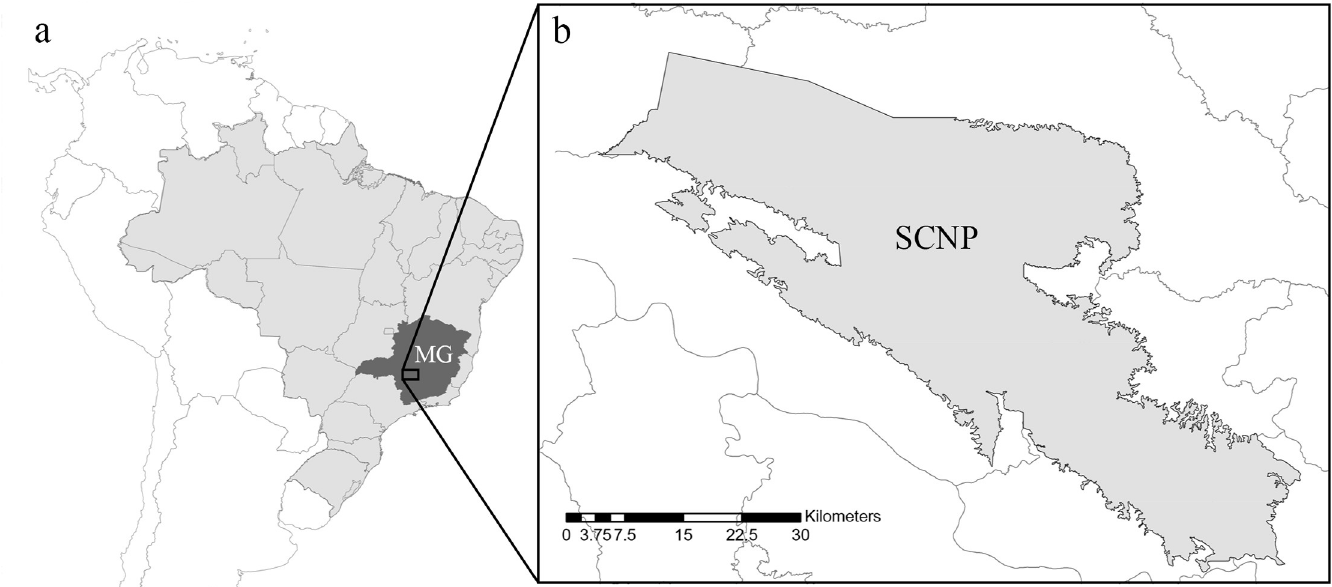
Fig 1. Map showing the locality of occurrence of Franciscobasis sonia and F . franciscoi . a: map of Brazil, with Minas Gerais state (MG) highlighted; b: Highlighted in light grey, the SCNP.